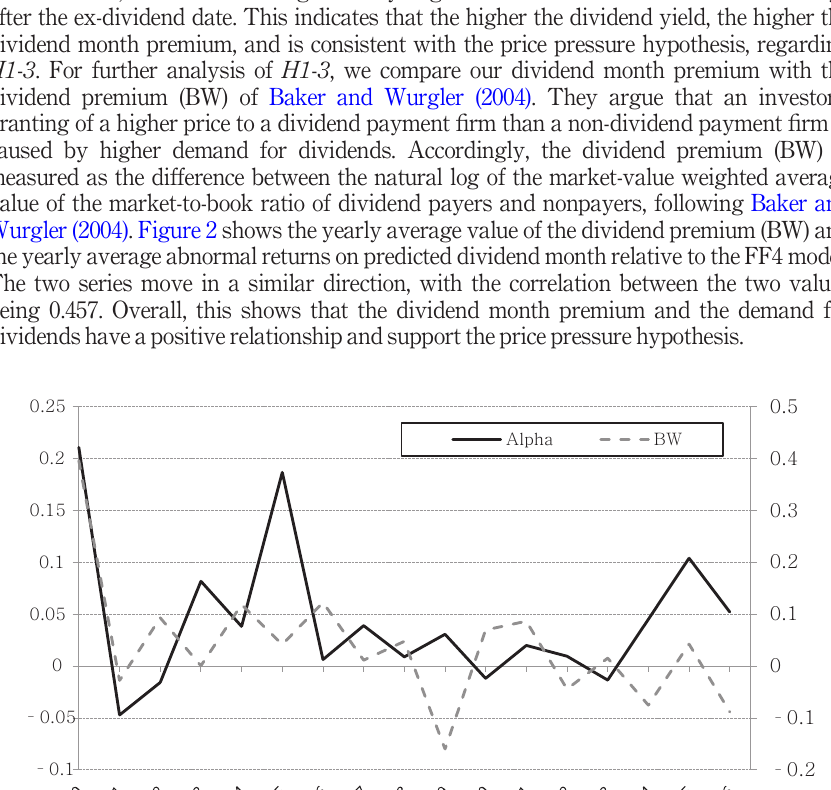
Figure 2. Dividend premium of Baker and Wurgler (2004)